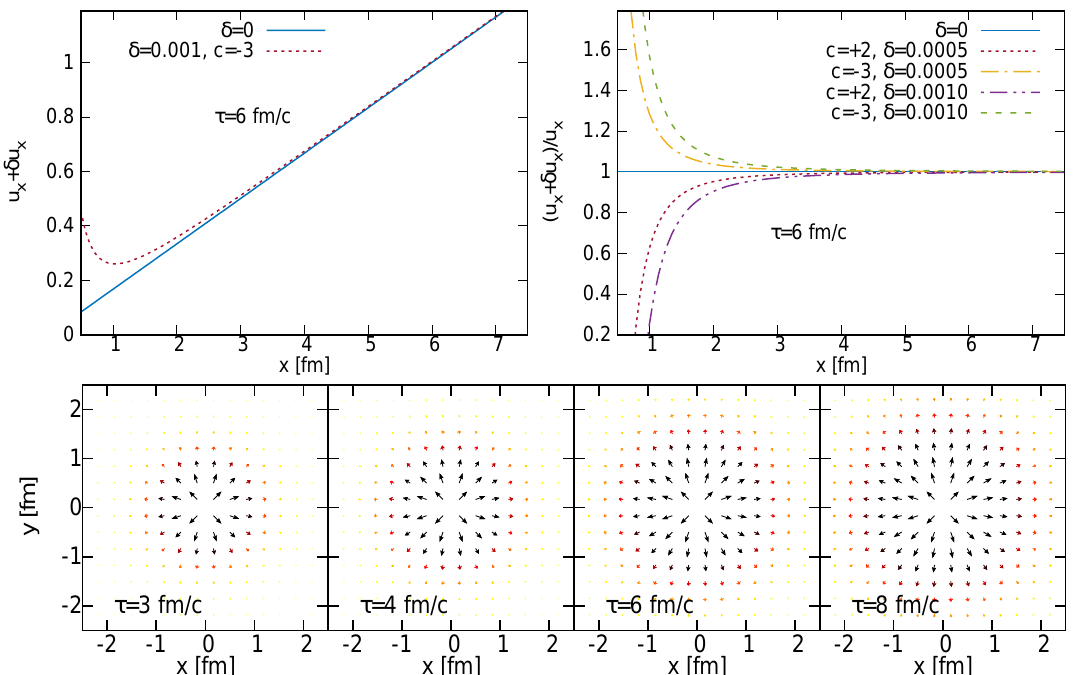
Figure 1. The perturbed flow field component ( u x + δ u x ) is shown in the left plot as a function of x , for τ = 6 fm/ c (the other parameters are given in the text). The right plot indicates the relative change ( u x + δ u x ) / u x for various δ and c values. The bottom plot shows the flow perturbation field ( δ u x , δ u y ) in the transverse plane, for various proper-time values.